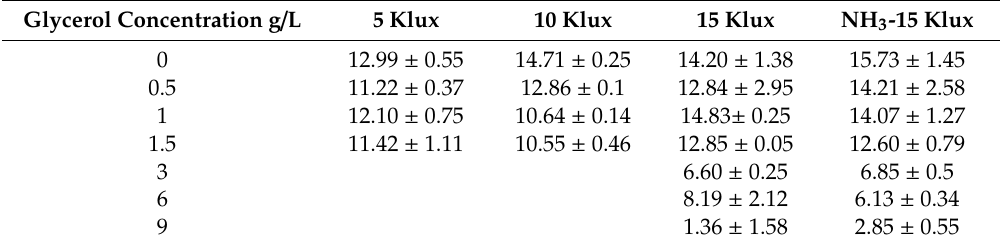
Table 5. Phycocyanin content of A. platensis cultivated under di ff erent glycerol concentrations and light